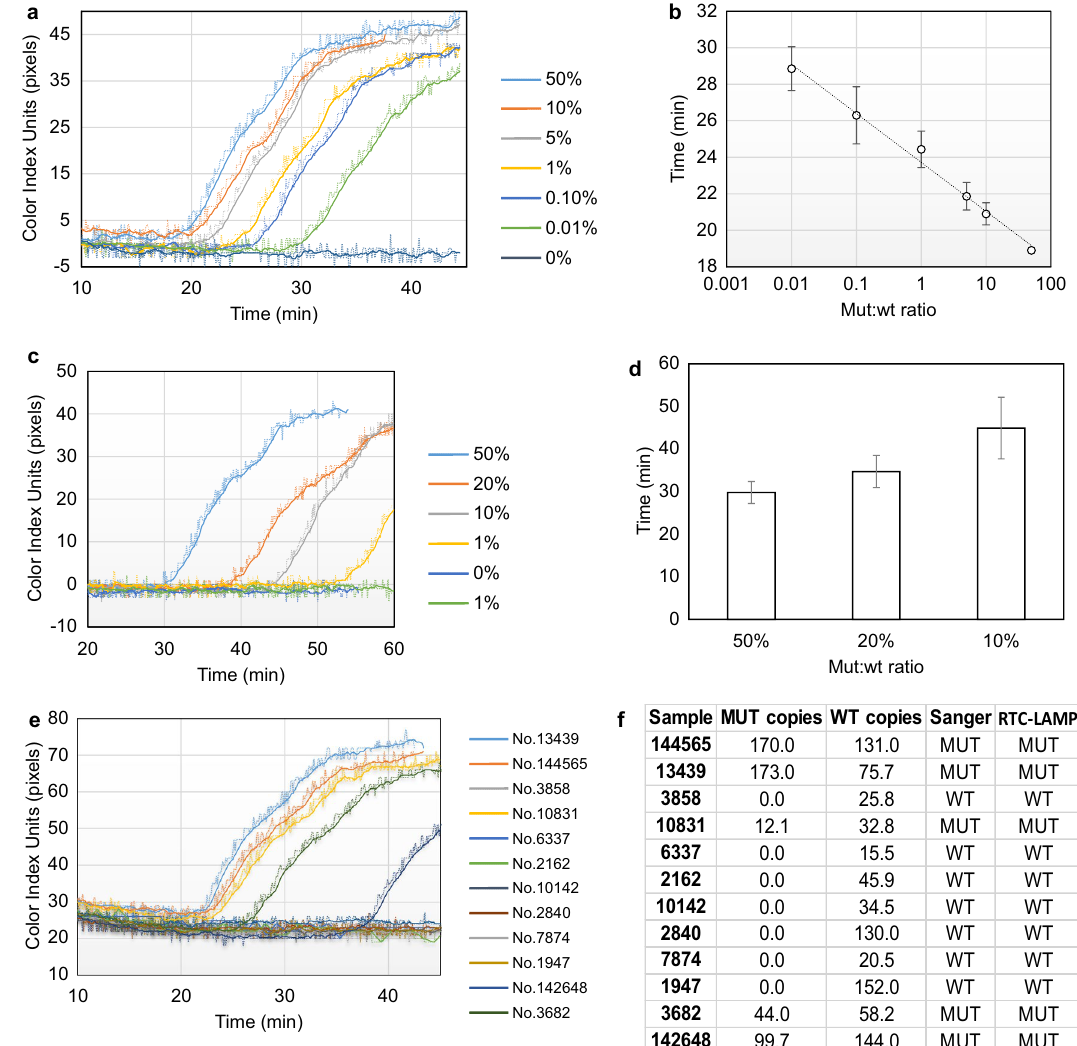
Figure 3. ( a ) Real-time colorimetric curves corresponding to mut:wt starting template ratios spanning more than four orders of magnitude. ( b ) Calibration curve produced from real-time data of triplicate colorimetric LAMP measurements with error bars representing standard deviation; y = − 1.165ln(x) + 23.72 (R 2 = 0.99). ( c ) Real-time data corresponding to tissue samples of various mut:wt ratios. The 1% was not consistently produced (yellow vs green line). ( d ) Comparison of real-time data for 10, 20 and 50% mut:wt tissue samples measured directly in the qcLAMPdevice without DNA purification. ( e ) Real time colorimetric LAMP results of 12 patient samples analyzed with the qcLAMP 3D device (blind tests). ( f ) Comparison of ddPCR, Sanger and qcLAMP test results of 12 clinical samples. The ddPCR method provided additional information regarding the concentration of mutant and wild type copies per analyzed